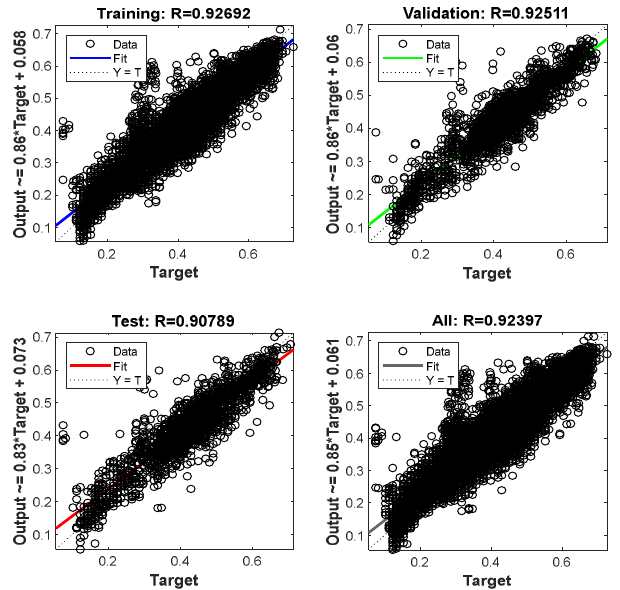
Figure 6 . NN learning generalization trajectory. Figure 6. NN learning generalization trajectory.